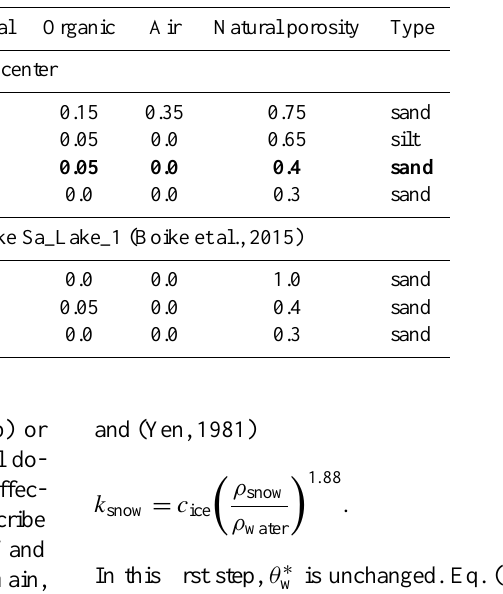
Table 3. Sediment stratigraphies of the validation runs, with volumetric fractions of the soil constituents and soil type for each layer given. Layers super-saturated with ice in